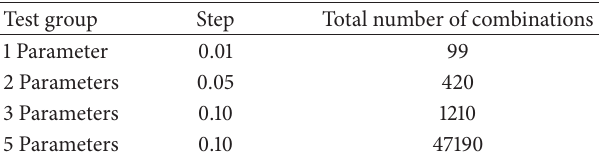
Table 4: Times of polynomiograph’s generation for 𝑝 1 using two parameters iterations.